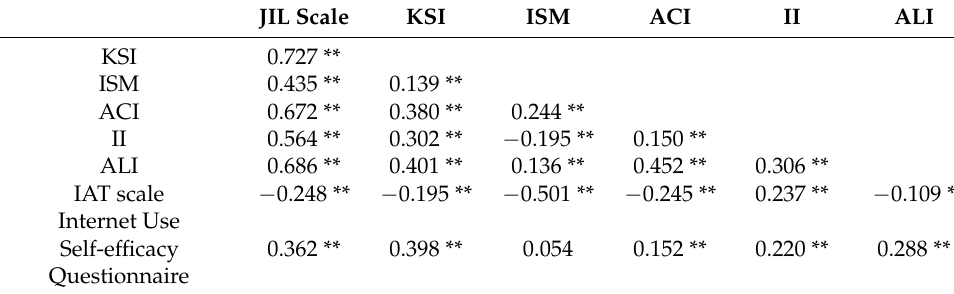
Table 7. Correlations for all study variables for Sample